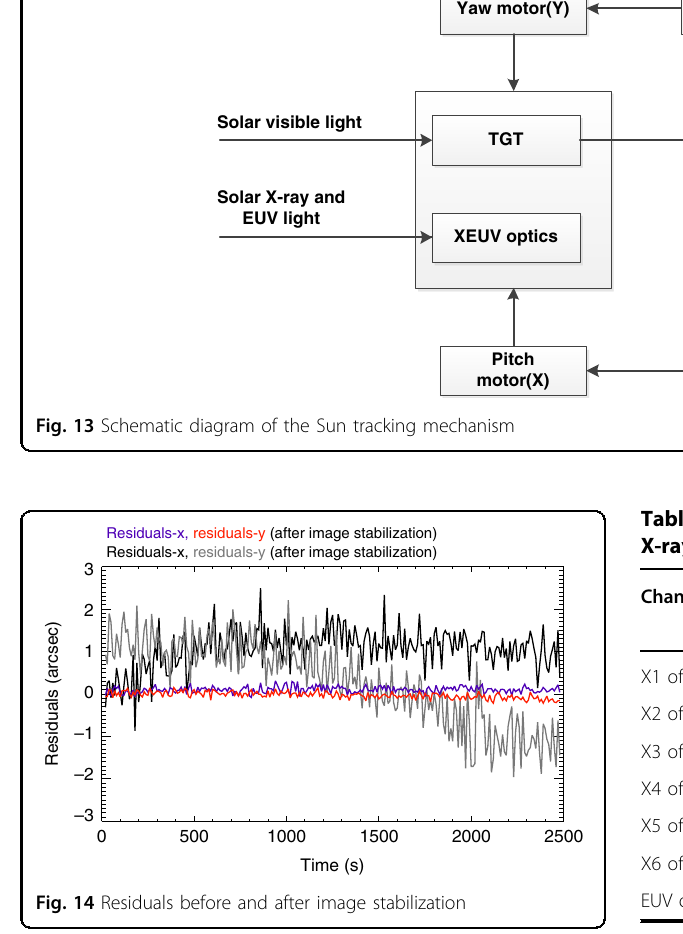
the log-polar transform and related algorithm. Since solar images are continually rotating, the imager fl at- fi eld matrix can be acquired at any time when the instrument is working.